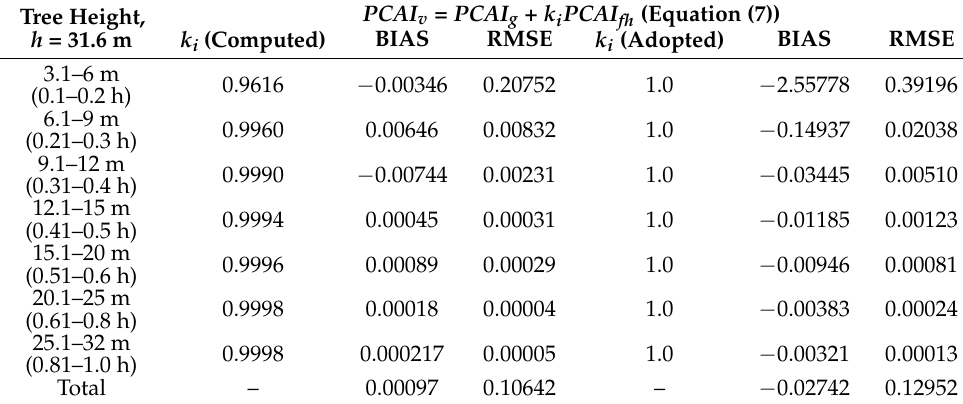
Table 4. Proportion of the PCAI fh in the PCAI v equation (Equation (7)).